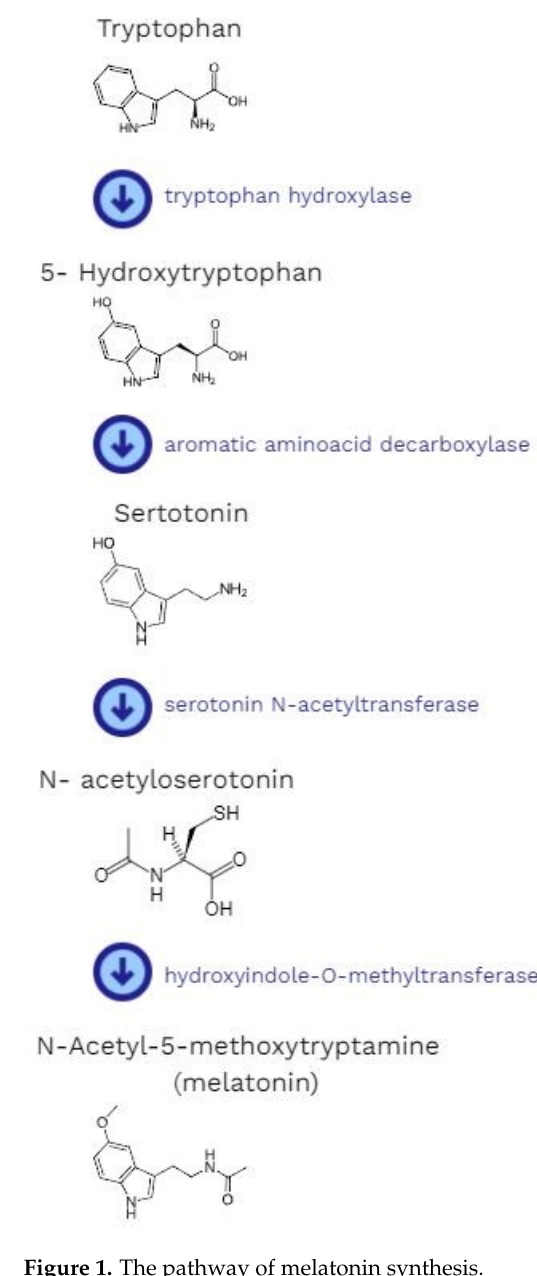
Figure 1. The pathway of melatonin synthesis.